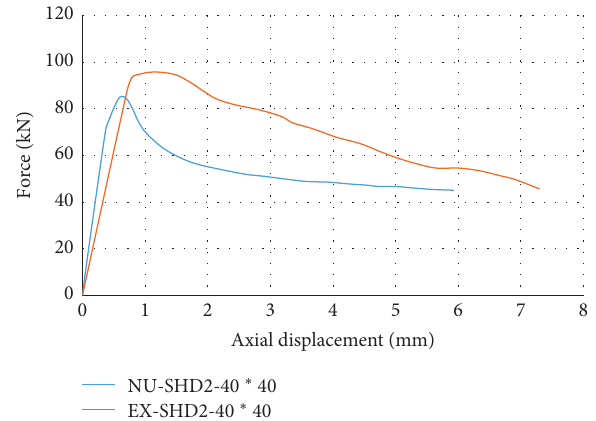
Figure 6: Force-displacement diagram of model and laboratory sample.